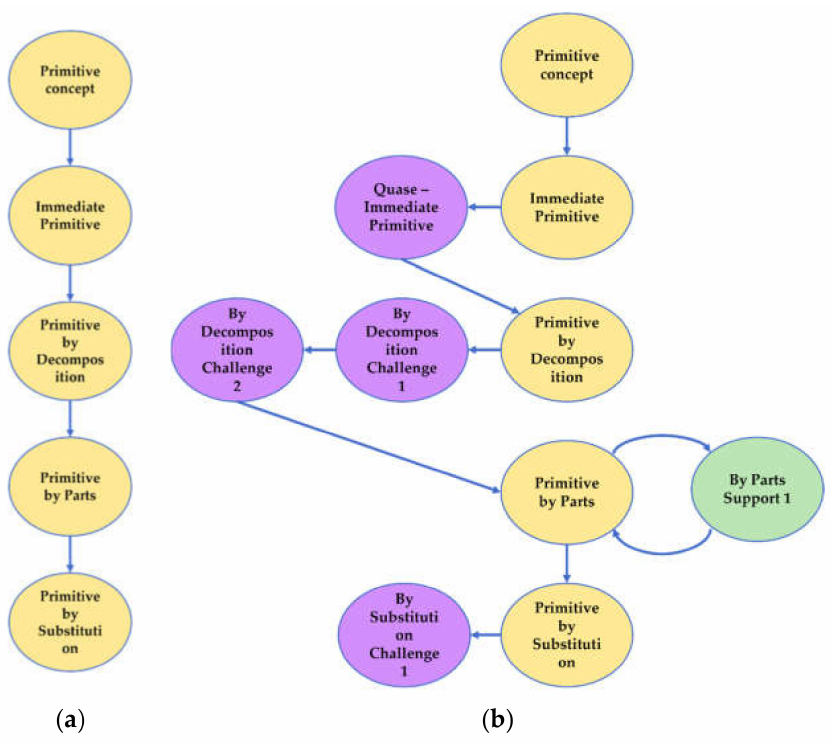
Figure 2. ( a ) A learning trajectory of the learning graph of Figure 1; ( b ) one possible learning path of the learning graph of Figure